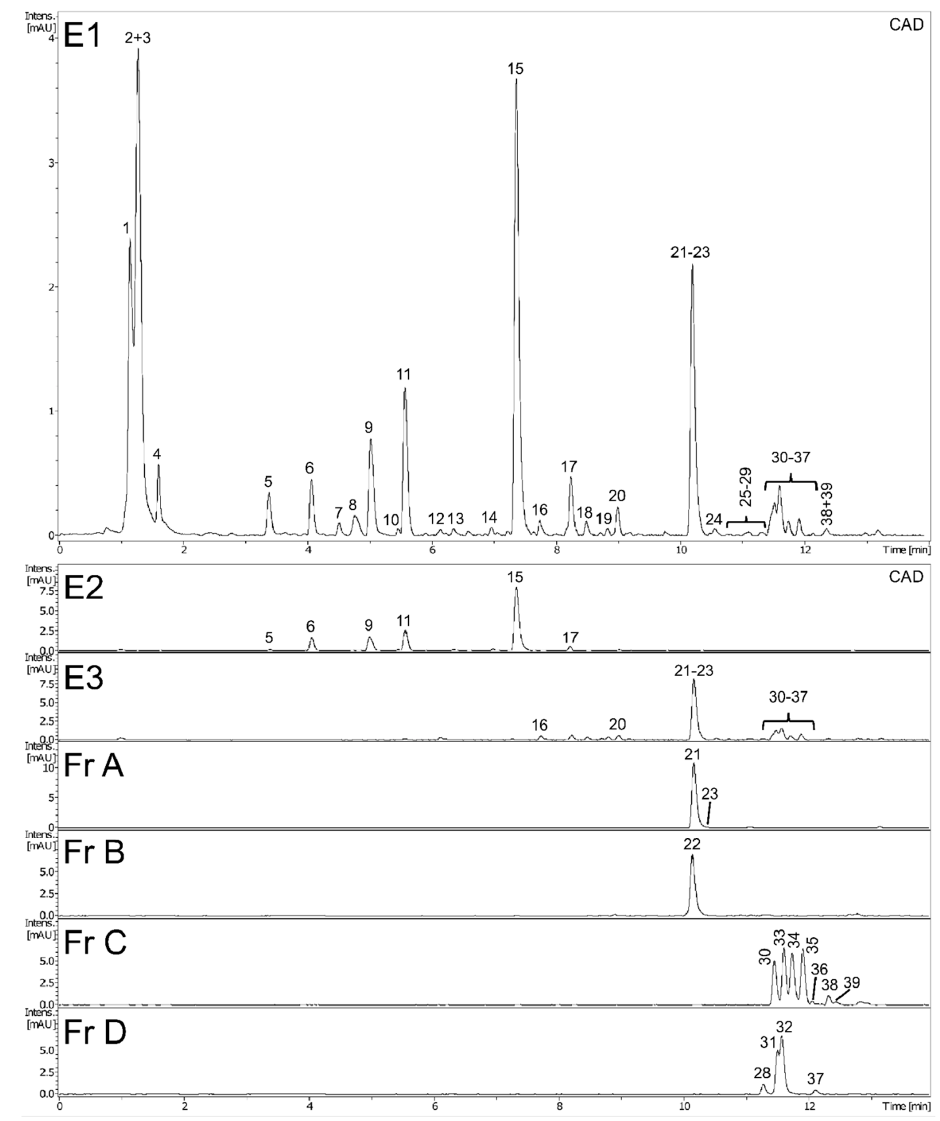
Figure 1. Phytochemical analysis of extracts (E1–E3) and flavonoid fractions (A–D) of dandelion fruits.